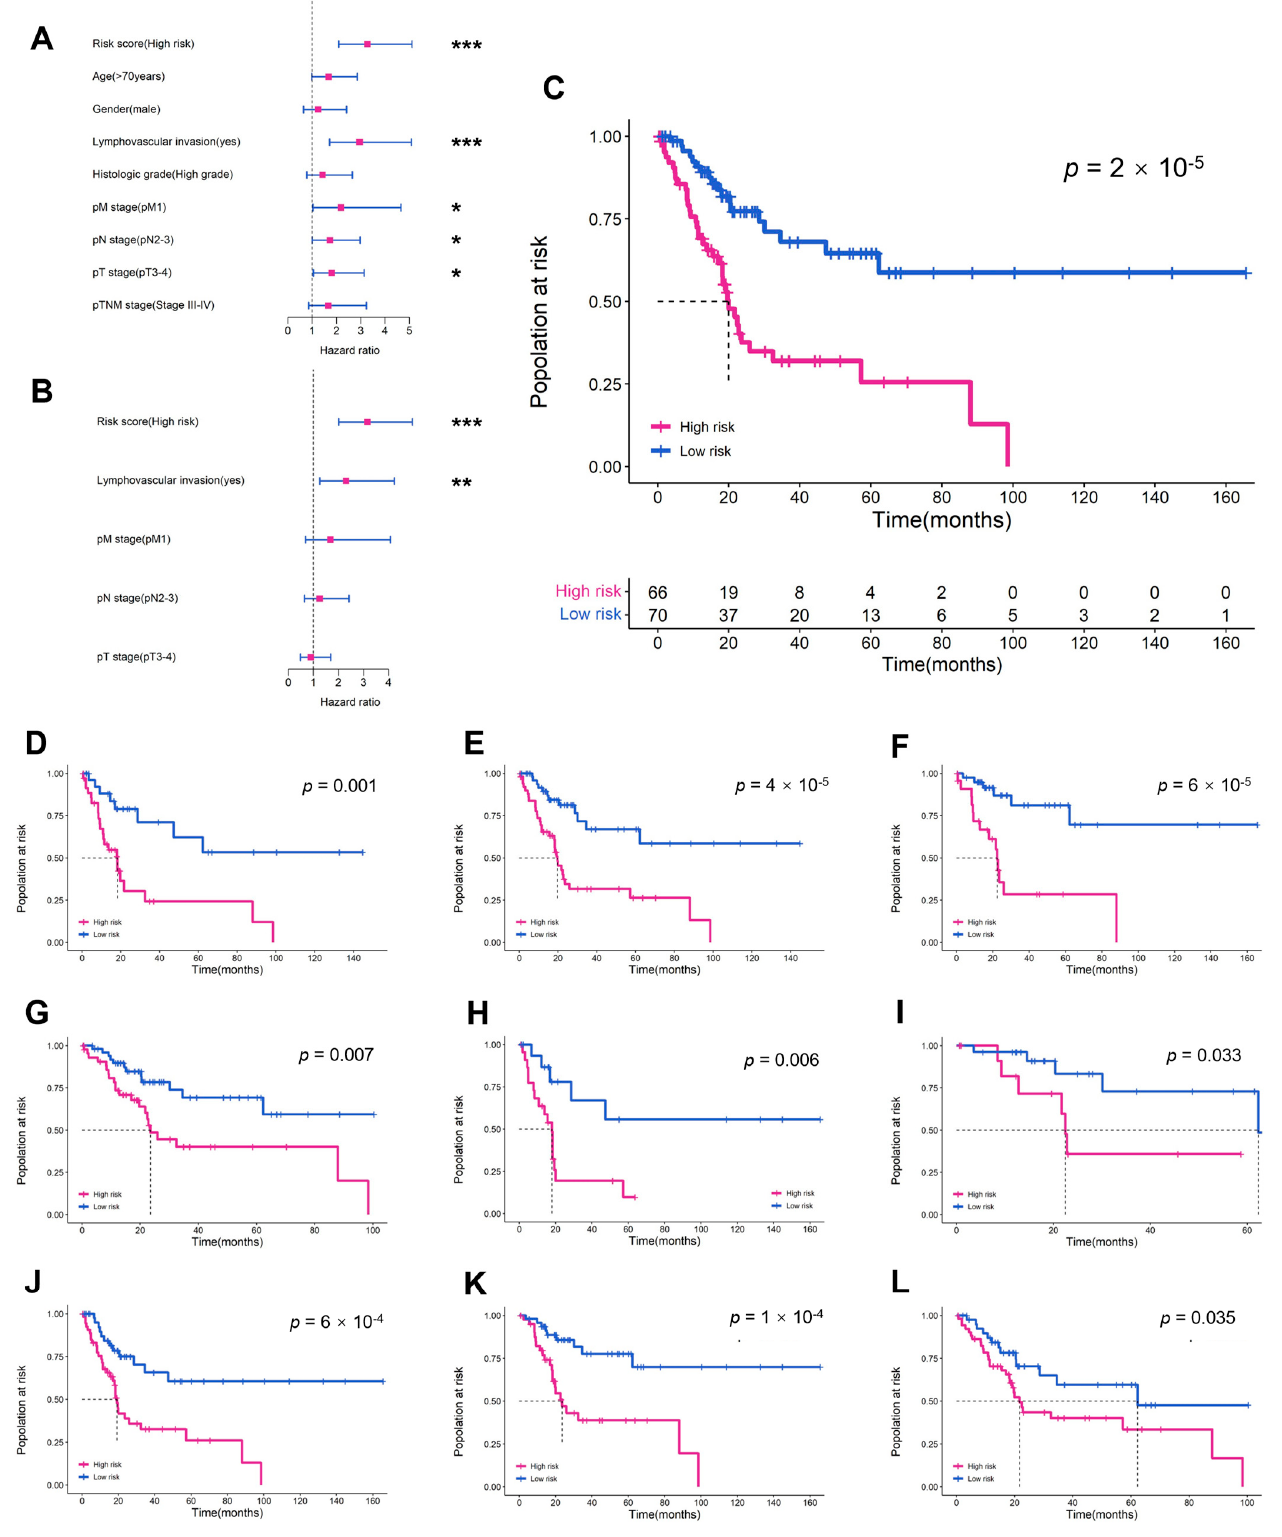
Figure 2. Prognostic value of MibcMLP-generated risk scores in the internal validation set. HR and 95% CI for MibcMLP and other clinicopathological features to predict survival in ( A ) univariate Cox and ( B ) multivariate Cox analyses. MibcMLP model scores were converted to binary scores (high risk or low risk) using the median risk score of the training set as a cut-off. K-M survival curves for ( C ) the entire internal validation set and the following subgroups: ( D ) age ≥ 70; ( E ) male; ( F ) pT stage